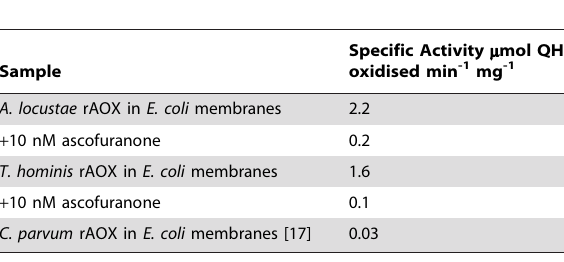
Table 1. Rates of oxidation of 150 m M ubiquinol-1 by these membrane fractions.